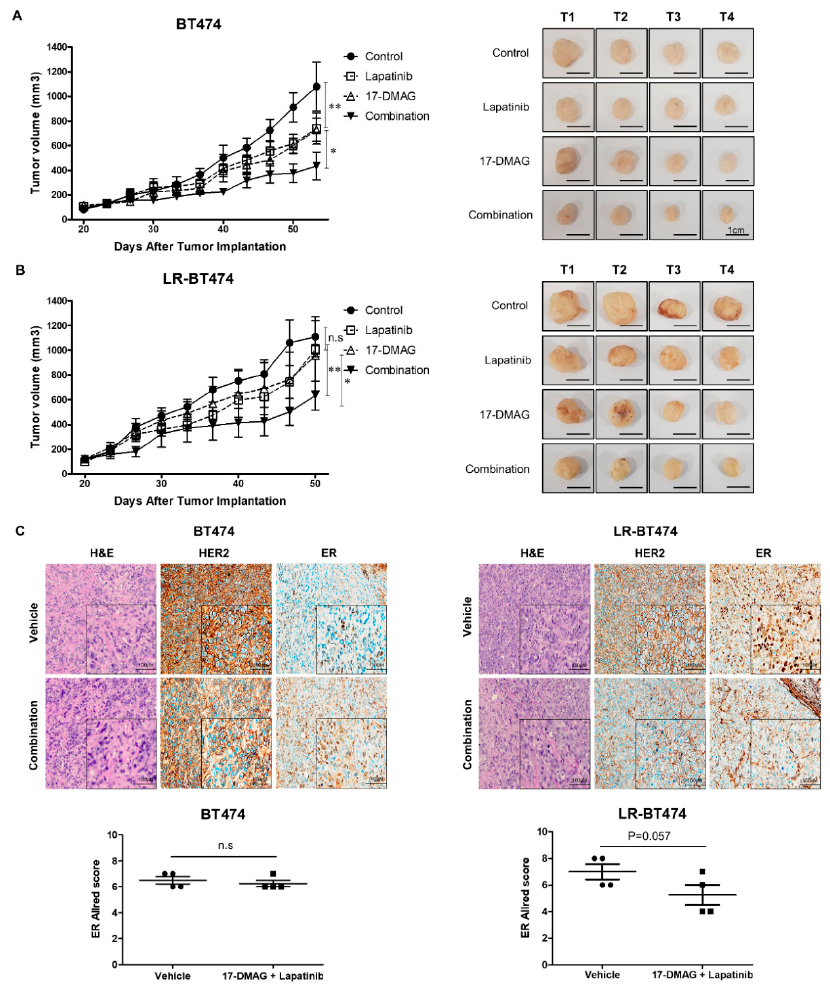
Figure 6. Antitumor efficacy of 17DMAG and lapatinib combination in BT474 and LR-BT474 xenograft models. ( A , B ) Mice were injected with BT474 and LR-BT474 cells on the flanks. After tumor formation, randomly grouped nude mice were treated with control, lapatinib (75 mg/kg), 17DMAG (5 mg/kg), or combination (lapatinib, 17DMAG) for 5 weeks. Tumor measurements were obtained twice a week. Average tumor volumes in control, lapatinib, 17-DMAG, and combination treatment groups are presented as mean ± SEM (*, p < 0.05; **, p < 0.01). Scale bars, 1 cm. ( C ) Representative image of immunohistochemical staining in BT474 and LR-BT474 tumors of xenograft models. Tumor sections from vehicle and combination groups were stained for HER2 and ER. Scale bars, 100 μ m. Scatter plot of ER Allred scores in BT474 and LR-BT474 xenograft tumors measured by IHC. Data are presented as mean ± SEM ( n = 4 in each group).